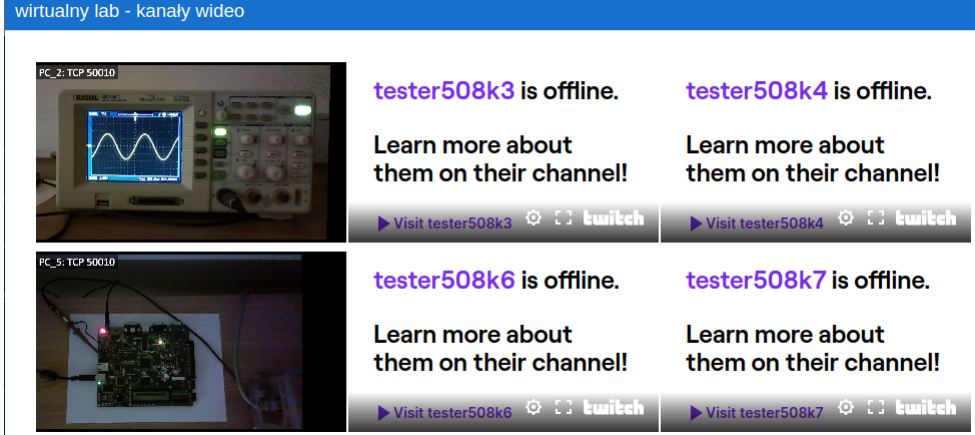
Figure 10. A preview of two channels. The design of the sine wave generator does not require the use of an LCD display. The first video channel is only for visual inspection of the oscilloscope probe